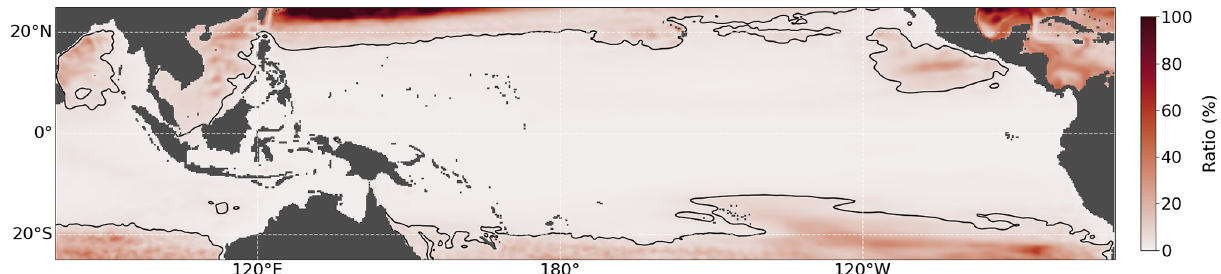
Figure 3. Ratio of SSH variance from O025-RYF90 and O025-HC. Black contour lines mark the 5% threshold. SDs are based on the period from 1958 to 2016. The global mean trends have been subtracted, and all data were smoothed with a 12-month running-mean window prior to